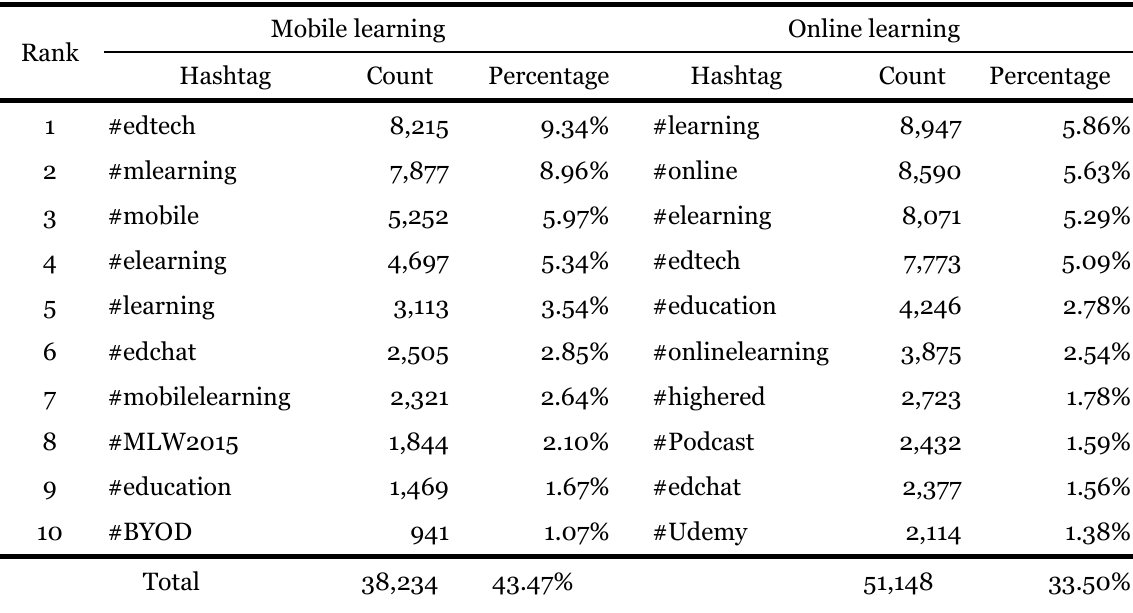
Top 10 Hashtags Related to Mobile Learning and Online